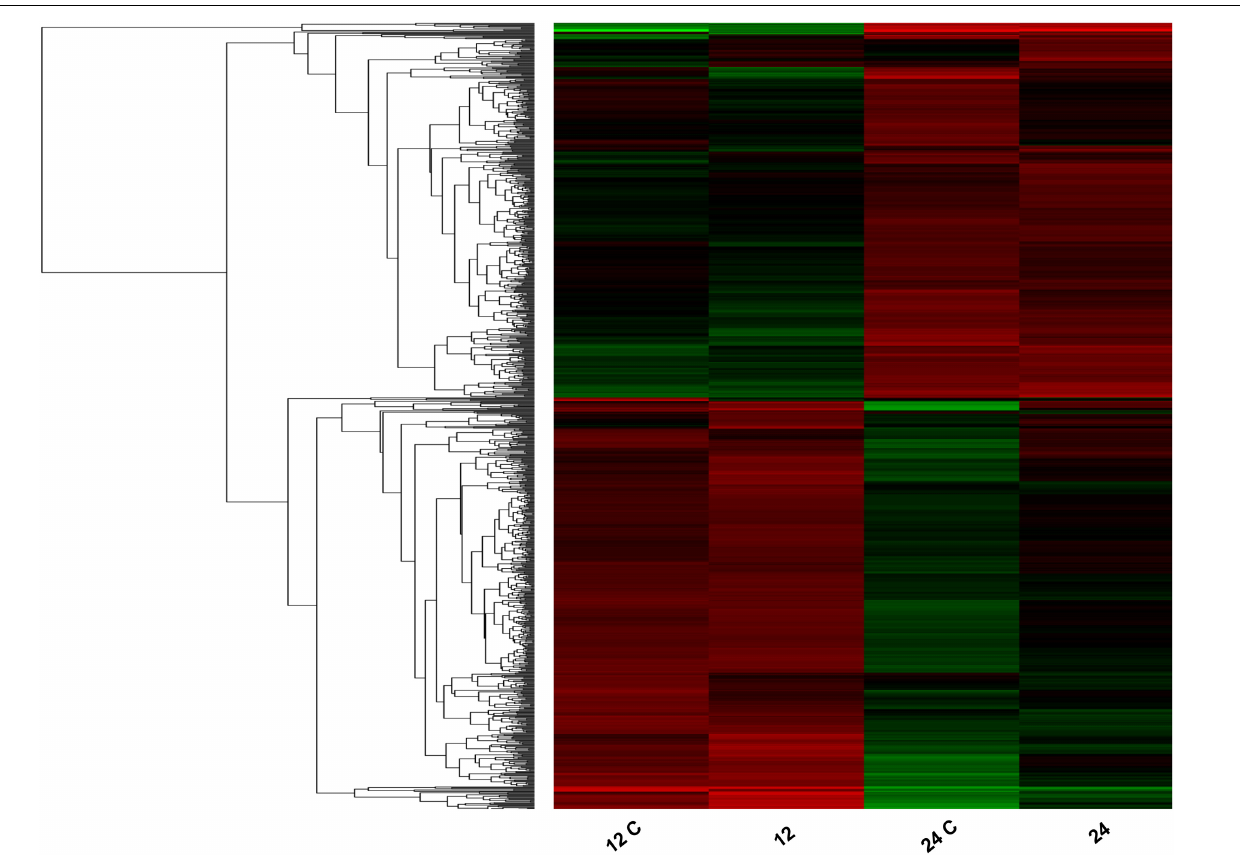
FIGURE 3 | Heatmap showing differential expression of bacterial genes in response to C. elegans . Total RNA was extracted from the bacterial cells with/without the host from two different phases of bacterial growth (exponential phase represented as 12 and 12 C whereas stationary phase represented as 24 and 24 C). Control samples of 12 h growth and 24 h growth are represented as 12 and 24, respectively whereas bacterial cells cultured with C. elegans are shown as 12 C and 24 C. Red bars show up-regulation and green bars show downregulation of genes. The intensity of the color is directly proportional to the magnitude of gene expression. Results of transcriptomics were cross verified by performing qRT-PCR on selected